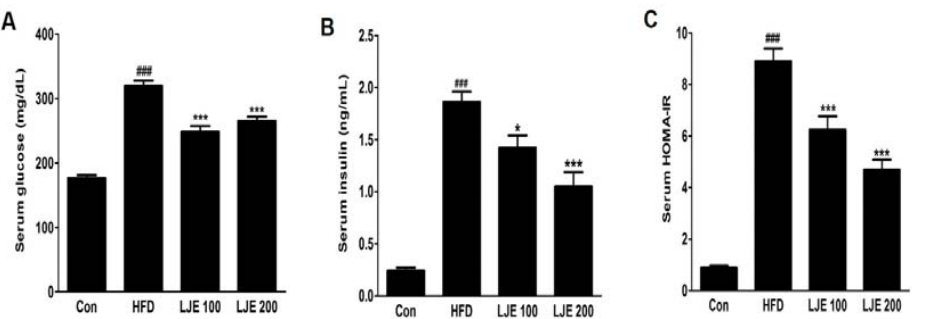
Figure 6. Effects of LJE on serum glucose, insulin, and homeostasis model assessment-insulin resistance (HOMA-IR) in HFD-fed mice. ( A ) Serum glucose levels; ( B ) Serum insulin levels; ( C ) Serum HOMA-IR. Con, normal control diet; HFD, high-fat diet; LJE 100, HFD plus LJE (100 mg/kg, peroral); LJE 200, HFD plus LJE (200 mg/kg, peroral). HOMA-IR, homeostasis model assessment values for insulin resistance. Data represent means ± SEM ( n = 8). ### p < 0.001 vs. Con; * p < 0.05, *** p < 0.001 vs. HFD.